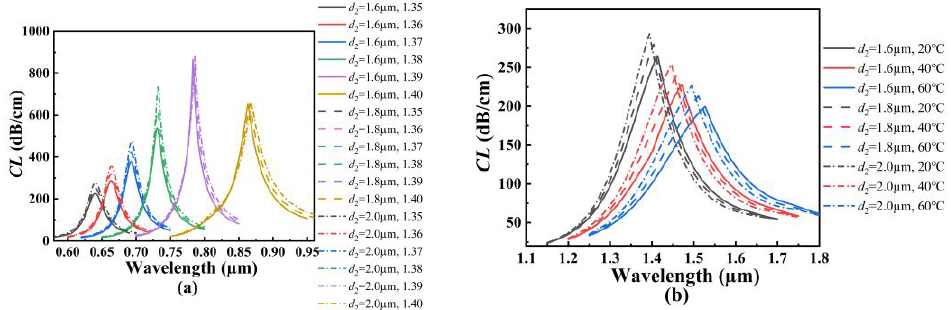
Figure 5. ( a ) The CL spectra of the core mode A when d 2 is set as 1.6, 1.8, and 2.0 μm, and when the analyte RI increases from 1.35 to 1.40, respectively. ( b ) The CL spectra of the core mode B when d 2 is set as 1.6, 1.8, and 2.0 μm, and the temperature is chosen as 20, 40, and 60 °C, respectively.